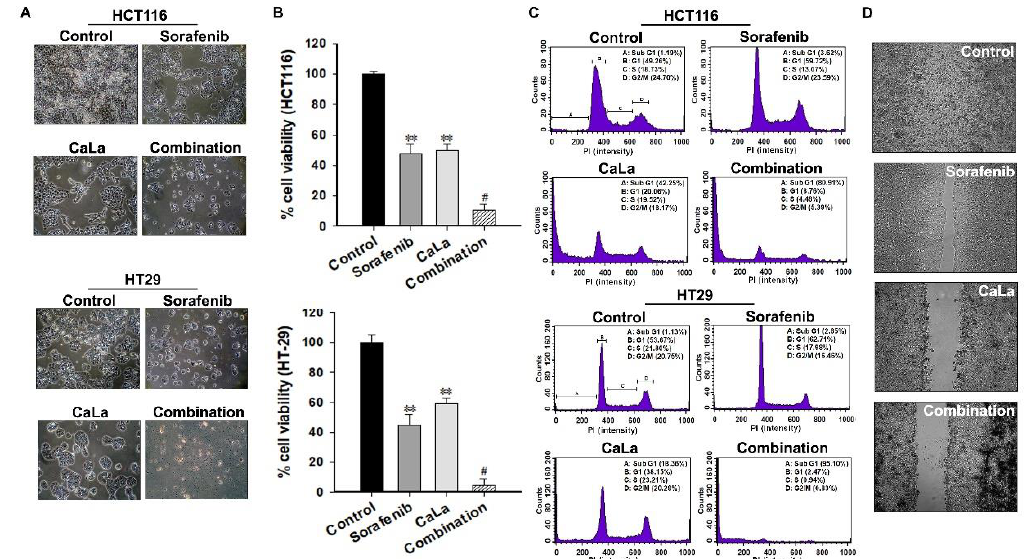
Figure 4. Confirmation of the enhanced anticancer effect of sorafenib through the calcium influx on colorectal cancer (CRC) cells. ( A ) Morphological changes in CRC cells were observed using an optical microscope. Scale bars: 100 μm. Enlarged pictures are provided in Supplementary Figure S4. ( B ) Quantitative analysis of the cell viability following treatment with the combination of sorafenib and lactate calcium salt (CaLa). ( C ) Representative cell cycle profiles of the control, 2.5 μM sorafenib, 2.5 mM CaLa, and combination-treated CRC cells. ( D ) A scratch wound healing assay was performed to determine the horizontal migration ability of CRC cells. All results were validated based on the quintuplicate analysis. ** p < 0.001 vs. Control and # p < 0.001 vs. sorafenib and CaLa. Results are mean